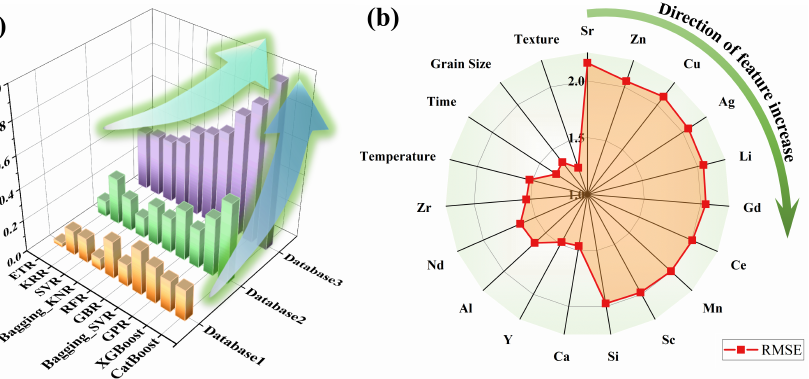
Figure 3. ( a ) Test set accuracy of different ML models on three datasets, ( b ) Variation of CatBoost model accuracy with the accumulation of descriptors.